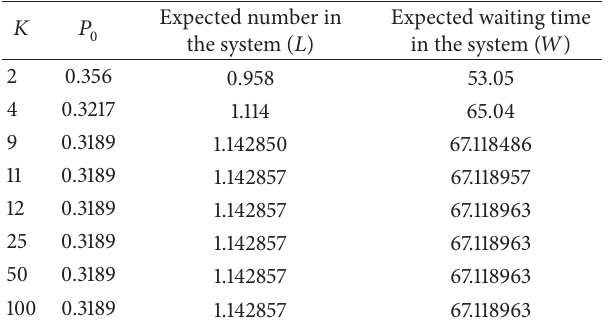
Table 1: [𝜆 = 1/35, 𝜇 1 = 1/40, 𝜇 = 1/30, 𝐶 = 1]